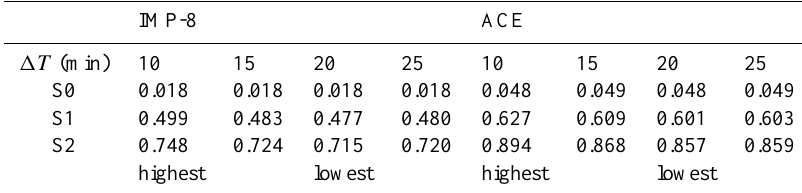
Table 4. Parameters of scatter plots PCN Vs Satellite derived from Stauning et al. (2006) Figs. 7.1 and